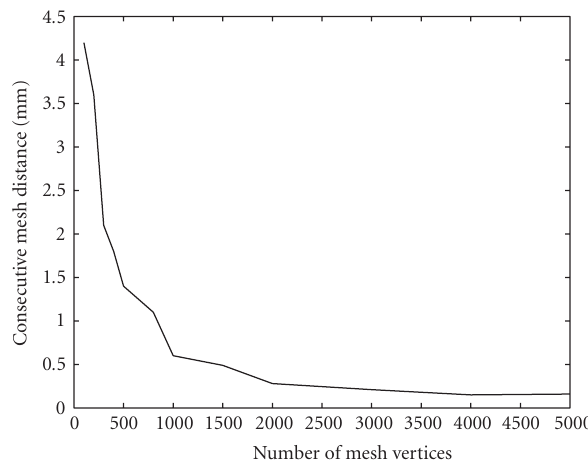
Figure 5: Average distance between consecutive meshes as a function of the number of mesh vertices.